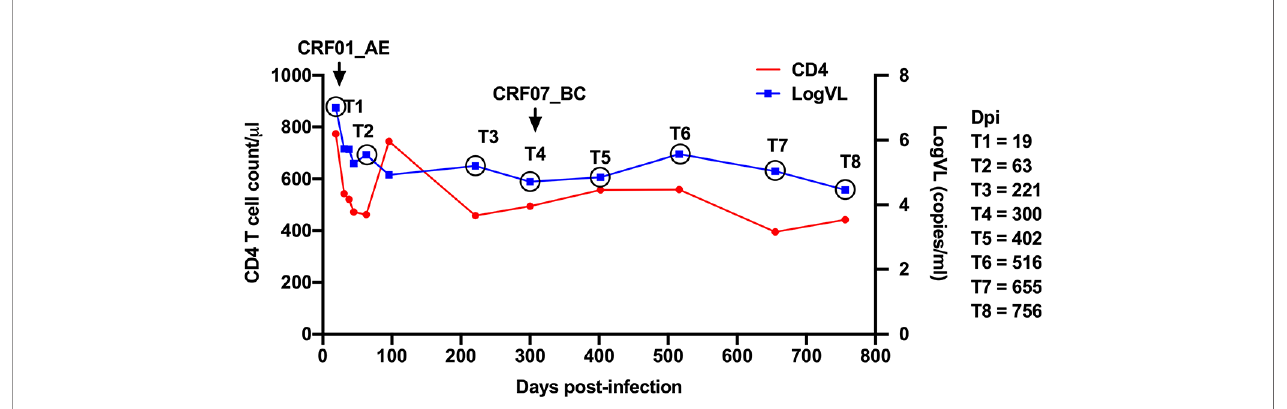
FIGURE 1 | Clinical data for patient LNA819. Longitudinal clinical data for plasma viral loads (VLs) (blue line) and CD4 + T-cell counts (red line) after acute HIV-1 infection. Infection with the HIV-1 CRF01_AE strain was detected at 19 days post-infection (dpi) (T1); superinfection with the CRF07_BC strain was detected at 300 dpi